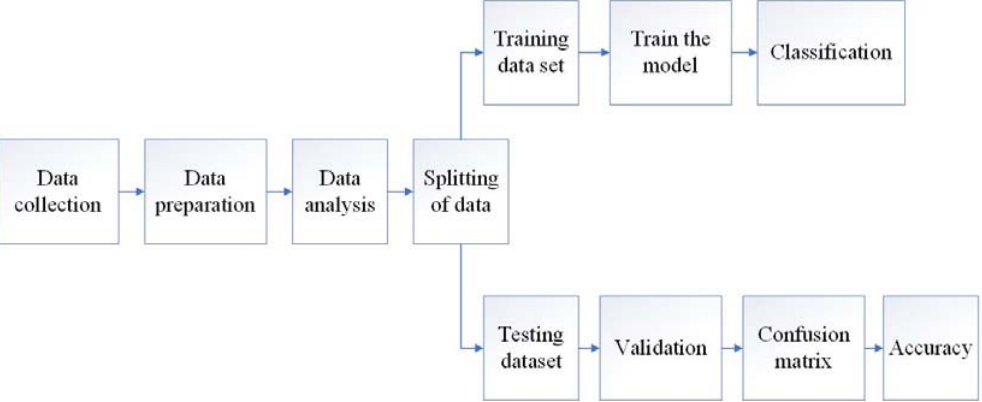
Figure 4. Flow chart for operator’s overall discomfort classification using a machine learning algorithm.